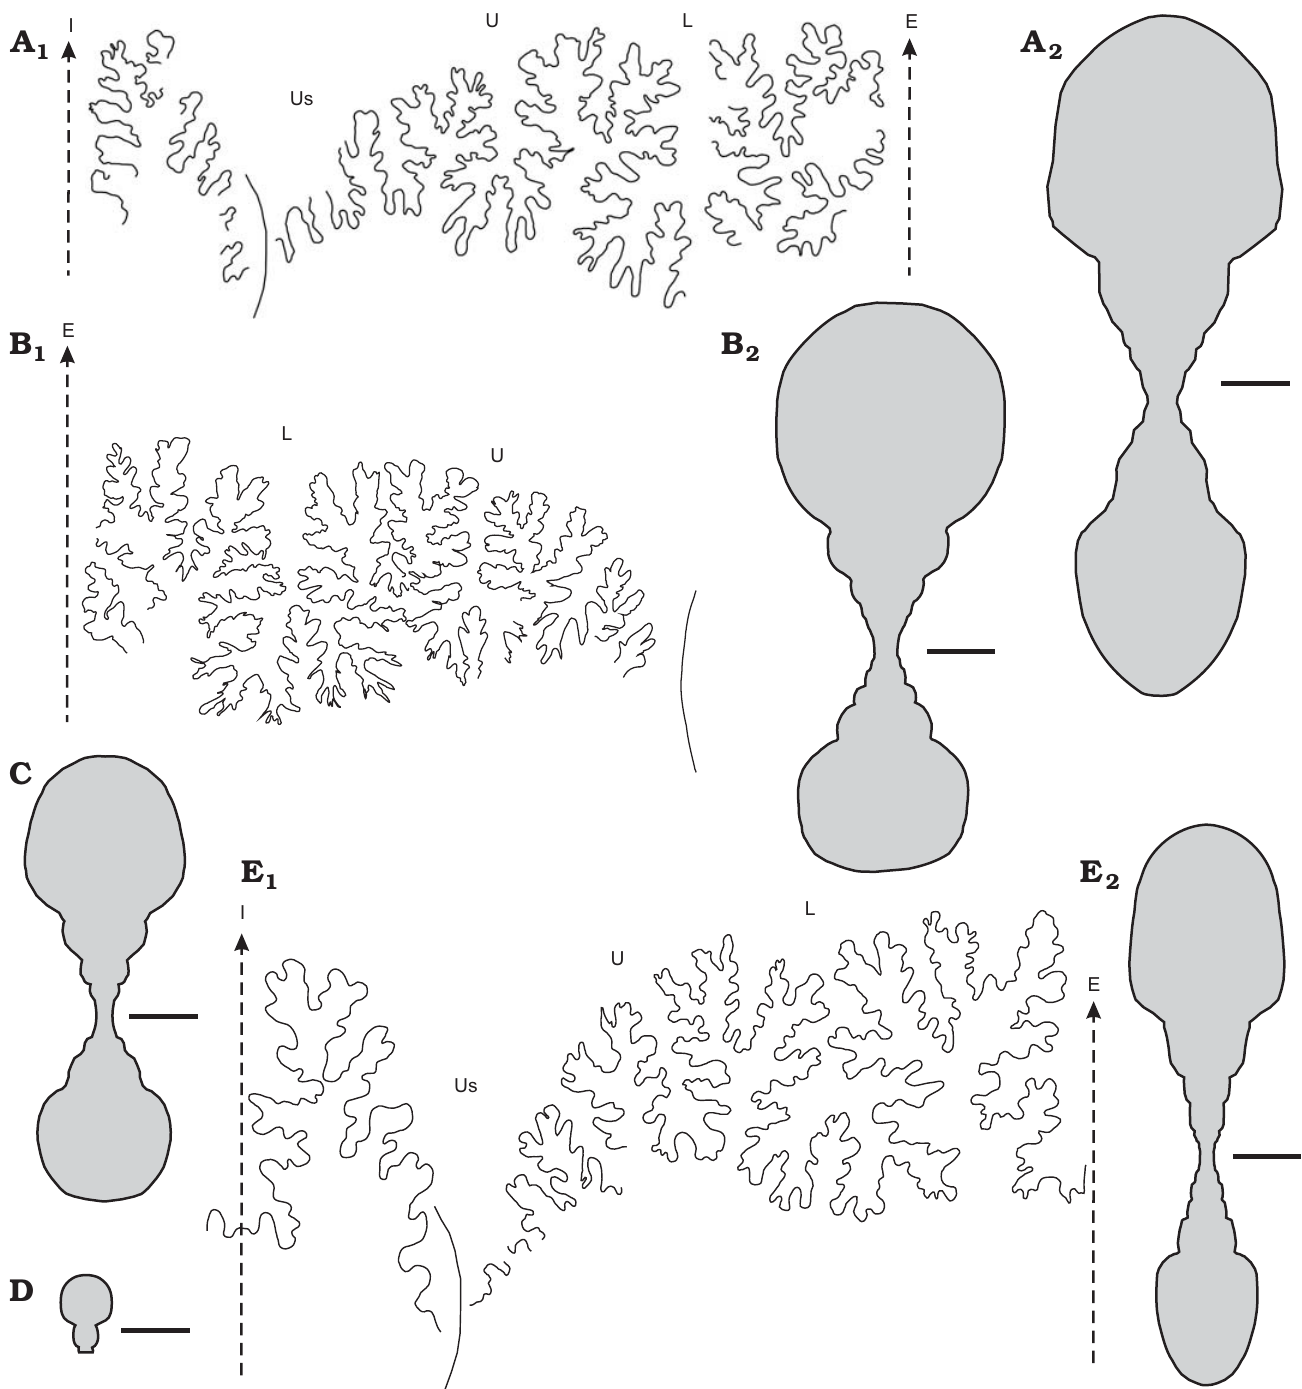
Fig. 6. The gaudryceratid ammonoid Anagaudryceras spp., from the Campanian (Cretaceous), Antarctica, Rabot Formation, Redonda Point locality (A–C), and from the late Campanian–early Maastrichtian (Cretaceous), Antarctica, Snow Hill Island Formation, Sanctuary Cliffs locality (D, E). A , B . Ana- gaudryceras calabozoi Raffi and Olivero sp. nov. A . CADIC PI 411, holotype, adult macroconch; suture line (A 1 ), transversal section (A 2 ). B . CADIC PI 472, adult microconch; suture line (B 1 ), transversal section (B 2 ). C . Anagaudryceras cf. A. politissimum (Kossmat, 1895), CADIC PI 455, transversal sec- tion. D . Anagaudryceras sanctuarium Raffi and Olivero sp. nov., CADIC PI 604, transversal section. E . Anagaudryceras subcompresum Raffi and Olivero sp. nov., CADIC PI 506, holotype, adult specimen; suture line (E 1 ), transversal section (E 2 ). Scale bars 10 mm. Abbreviations: E, external lobe; I, internal lobe; L, lateral lobe; U, umbilical lobe; Us, septal